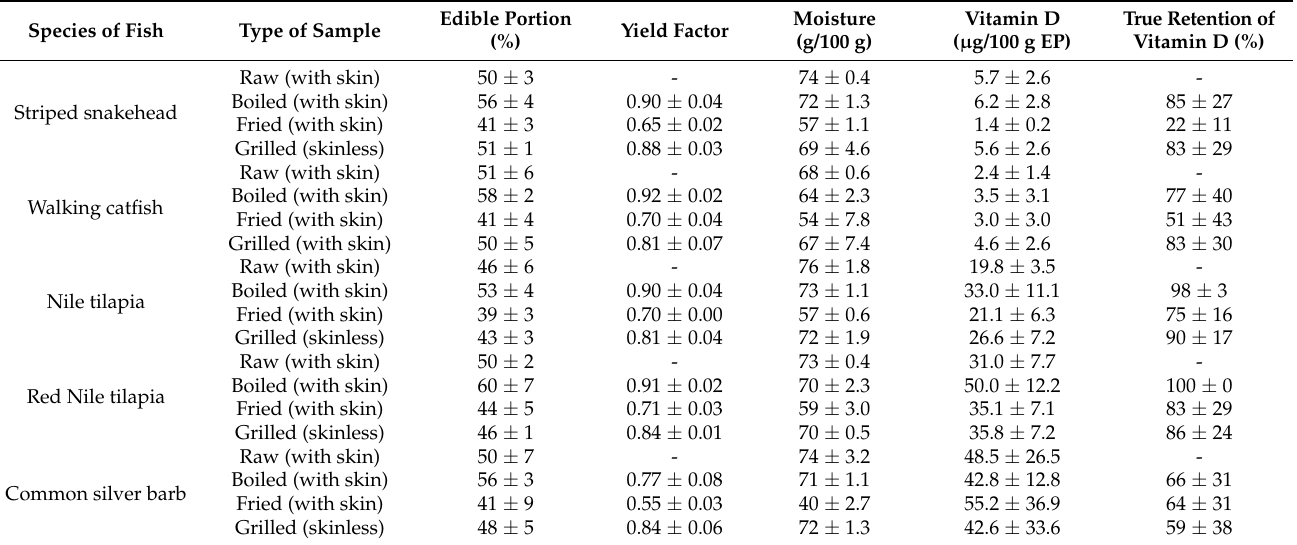
Table 3. Percentage of edible portion, yield factor, moisture, vitamin D, and true retention of 3 individual sets from each type of freshwater fish, data expressed as mean ± SD ( n =